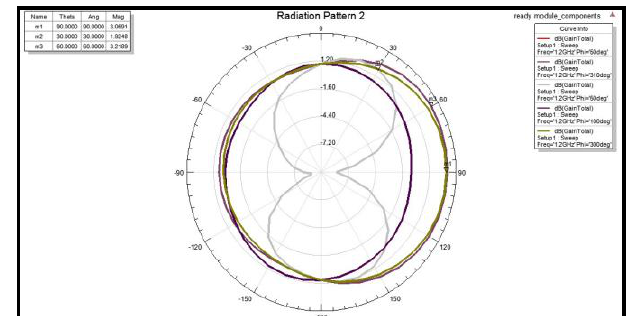
Figure 5: Simulated Return loss for dipole antenna.